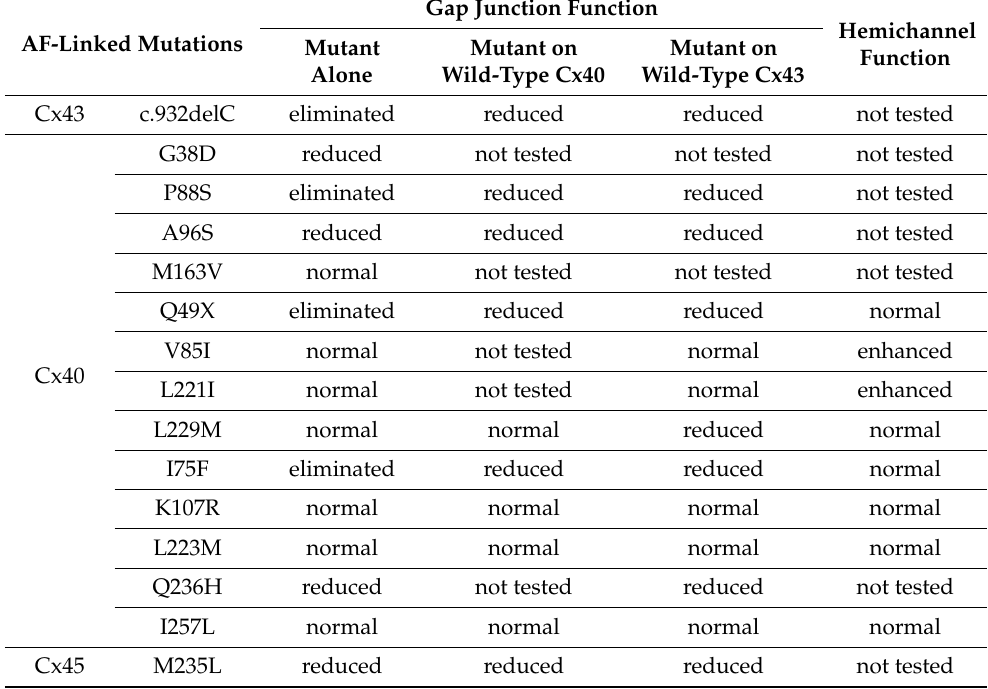
Table 1. Summary of functional characteristics of AF-linked myocardial connexin mutants. Gap Junction Function Hemichannel AF-Linked Mutations FunctionMutant Mutant on Mutant Alone Wild-Type Cx40